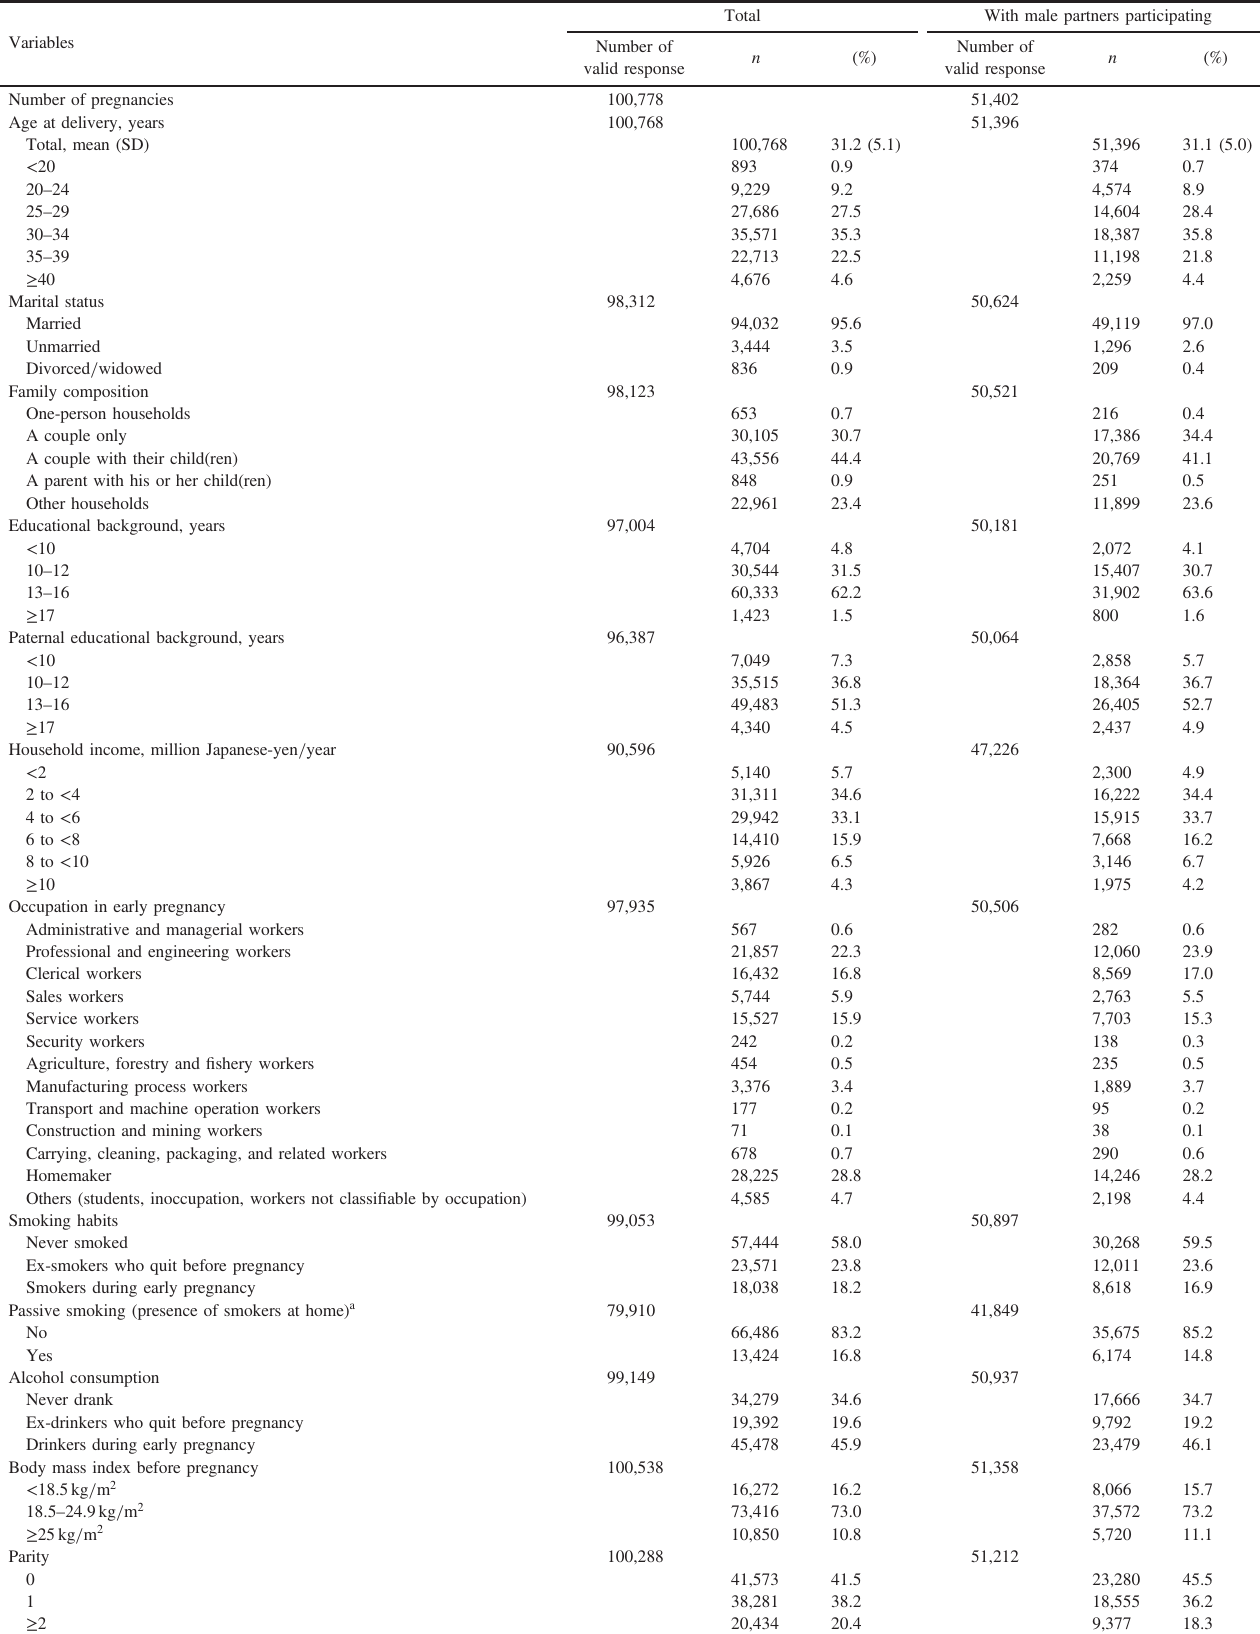
Total With male partners participating Number of Number of n (%) n (%) valid response valid response